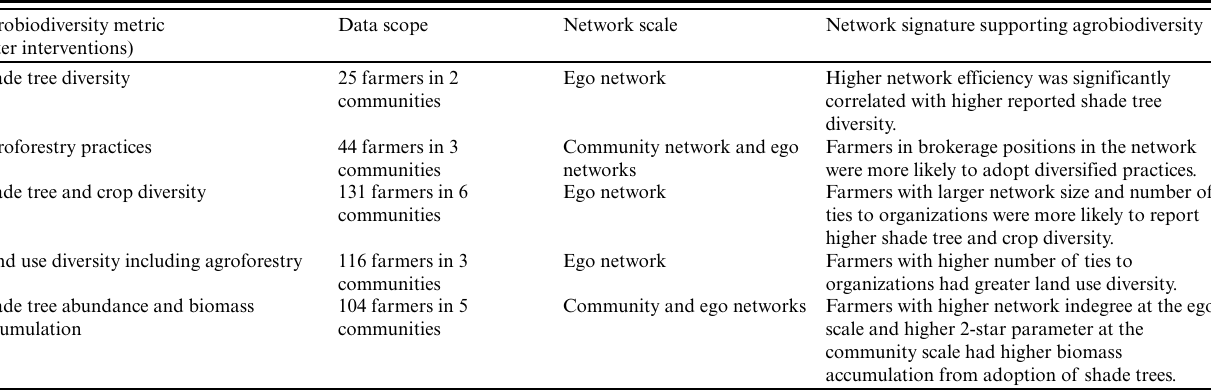
Table 2 . Summary of findings including agrobiodiversity practice after an intervention, data scope, network scale, and network signature that supports